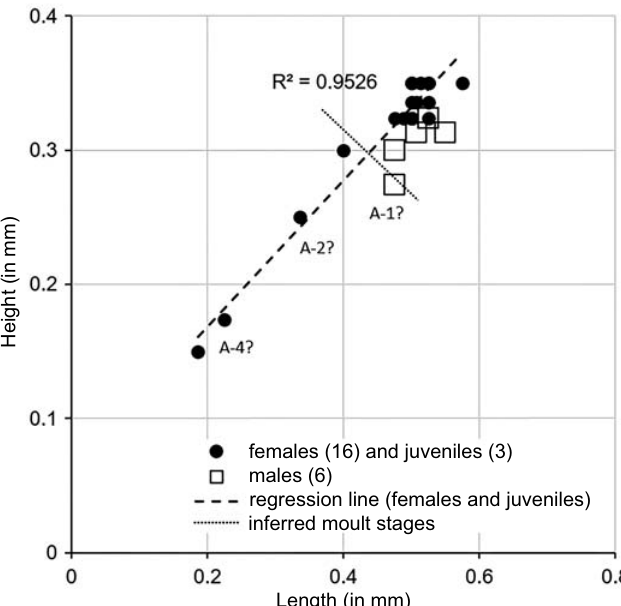
Fig. 13. Length versus height plots for Minyocythere angulata sp. nov. A-1, A-2, A-4, estimated growth (moult)